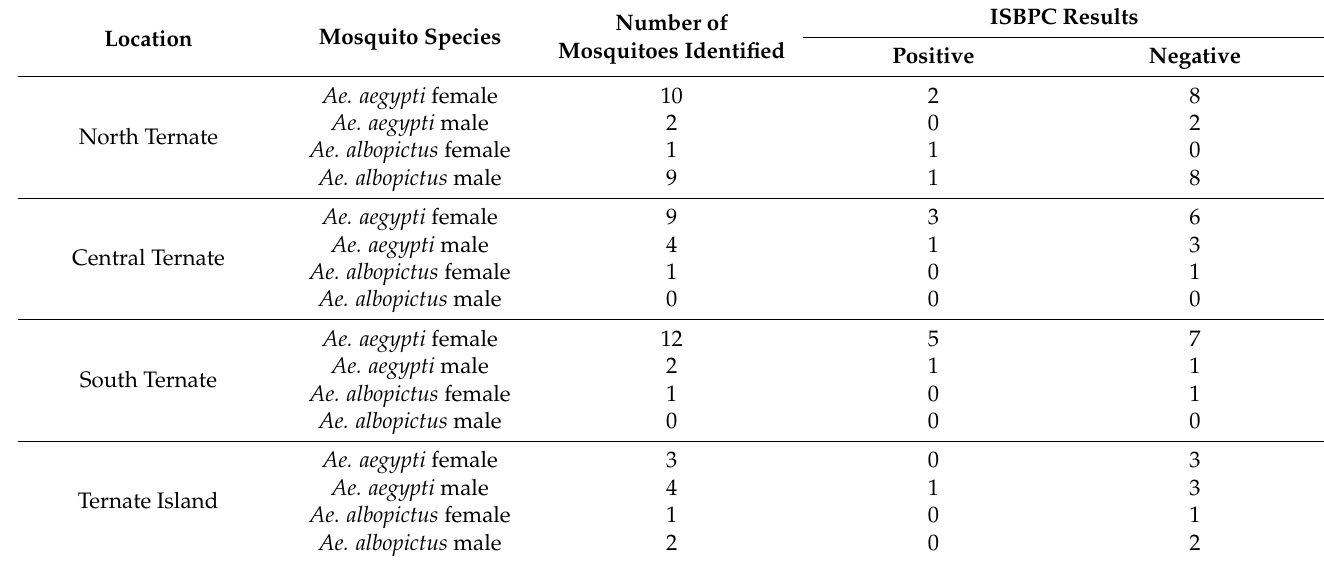
Table 1. ISBPC examination results of Aedes spp. specimen in four Ternate City